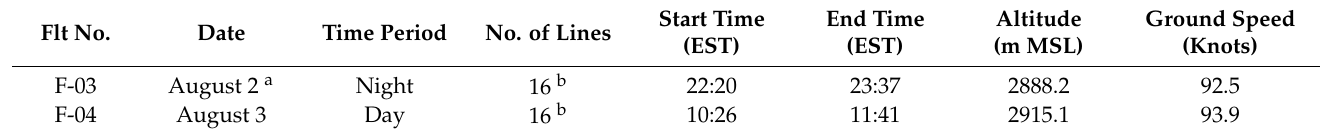
Table 1. Summary of presented FLIR data acquired over the Sioux Lookout (SLK-37) site, located near Pickle Lake, Northern Ontario, Canada, during the 2017 campaign. Average altitude and ground speed were extracted from the aircraft’s avionics GPS system. Flt No.